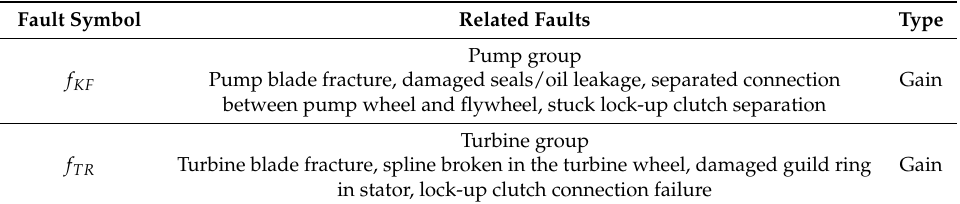
Table 2. Fault variables and their types, and the relationships between variables and critical faults in the